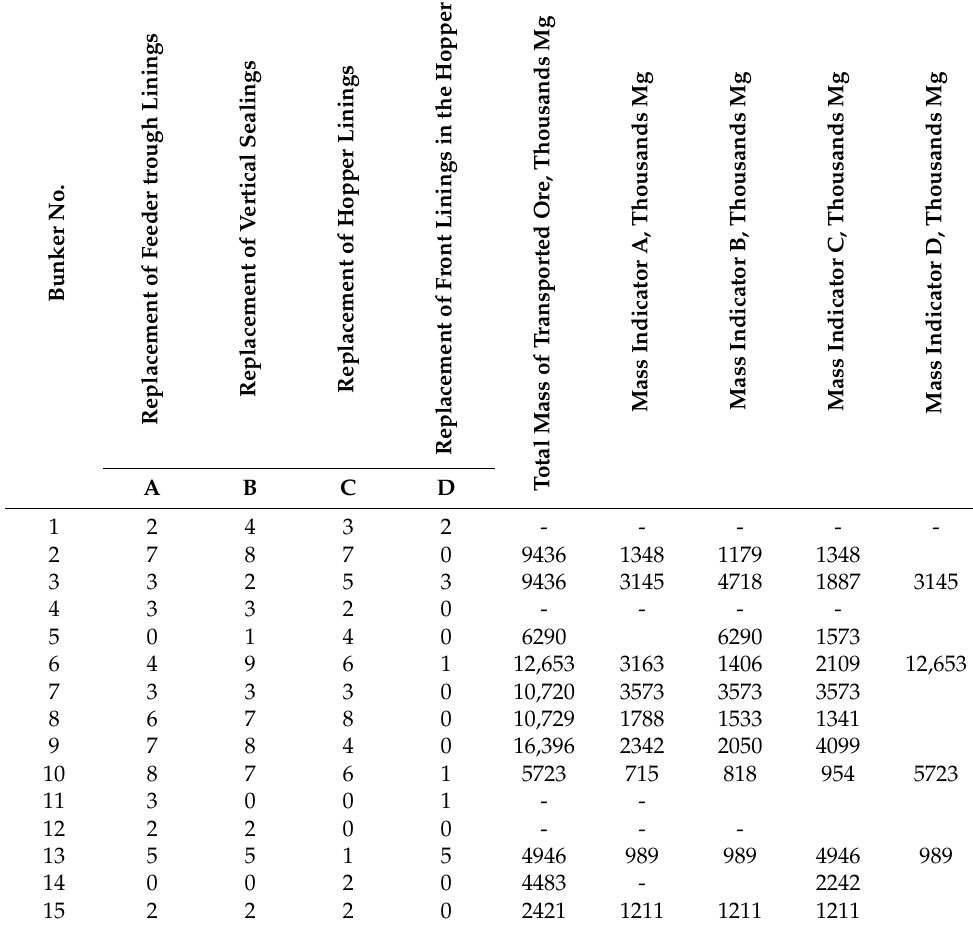
Table 4. Values of the mass indicator in relation to the amount of the transported